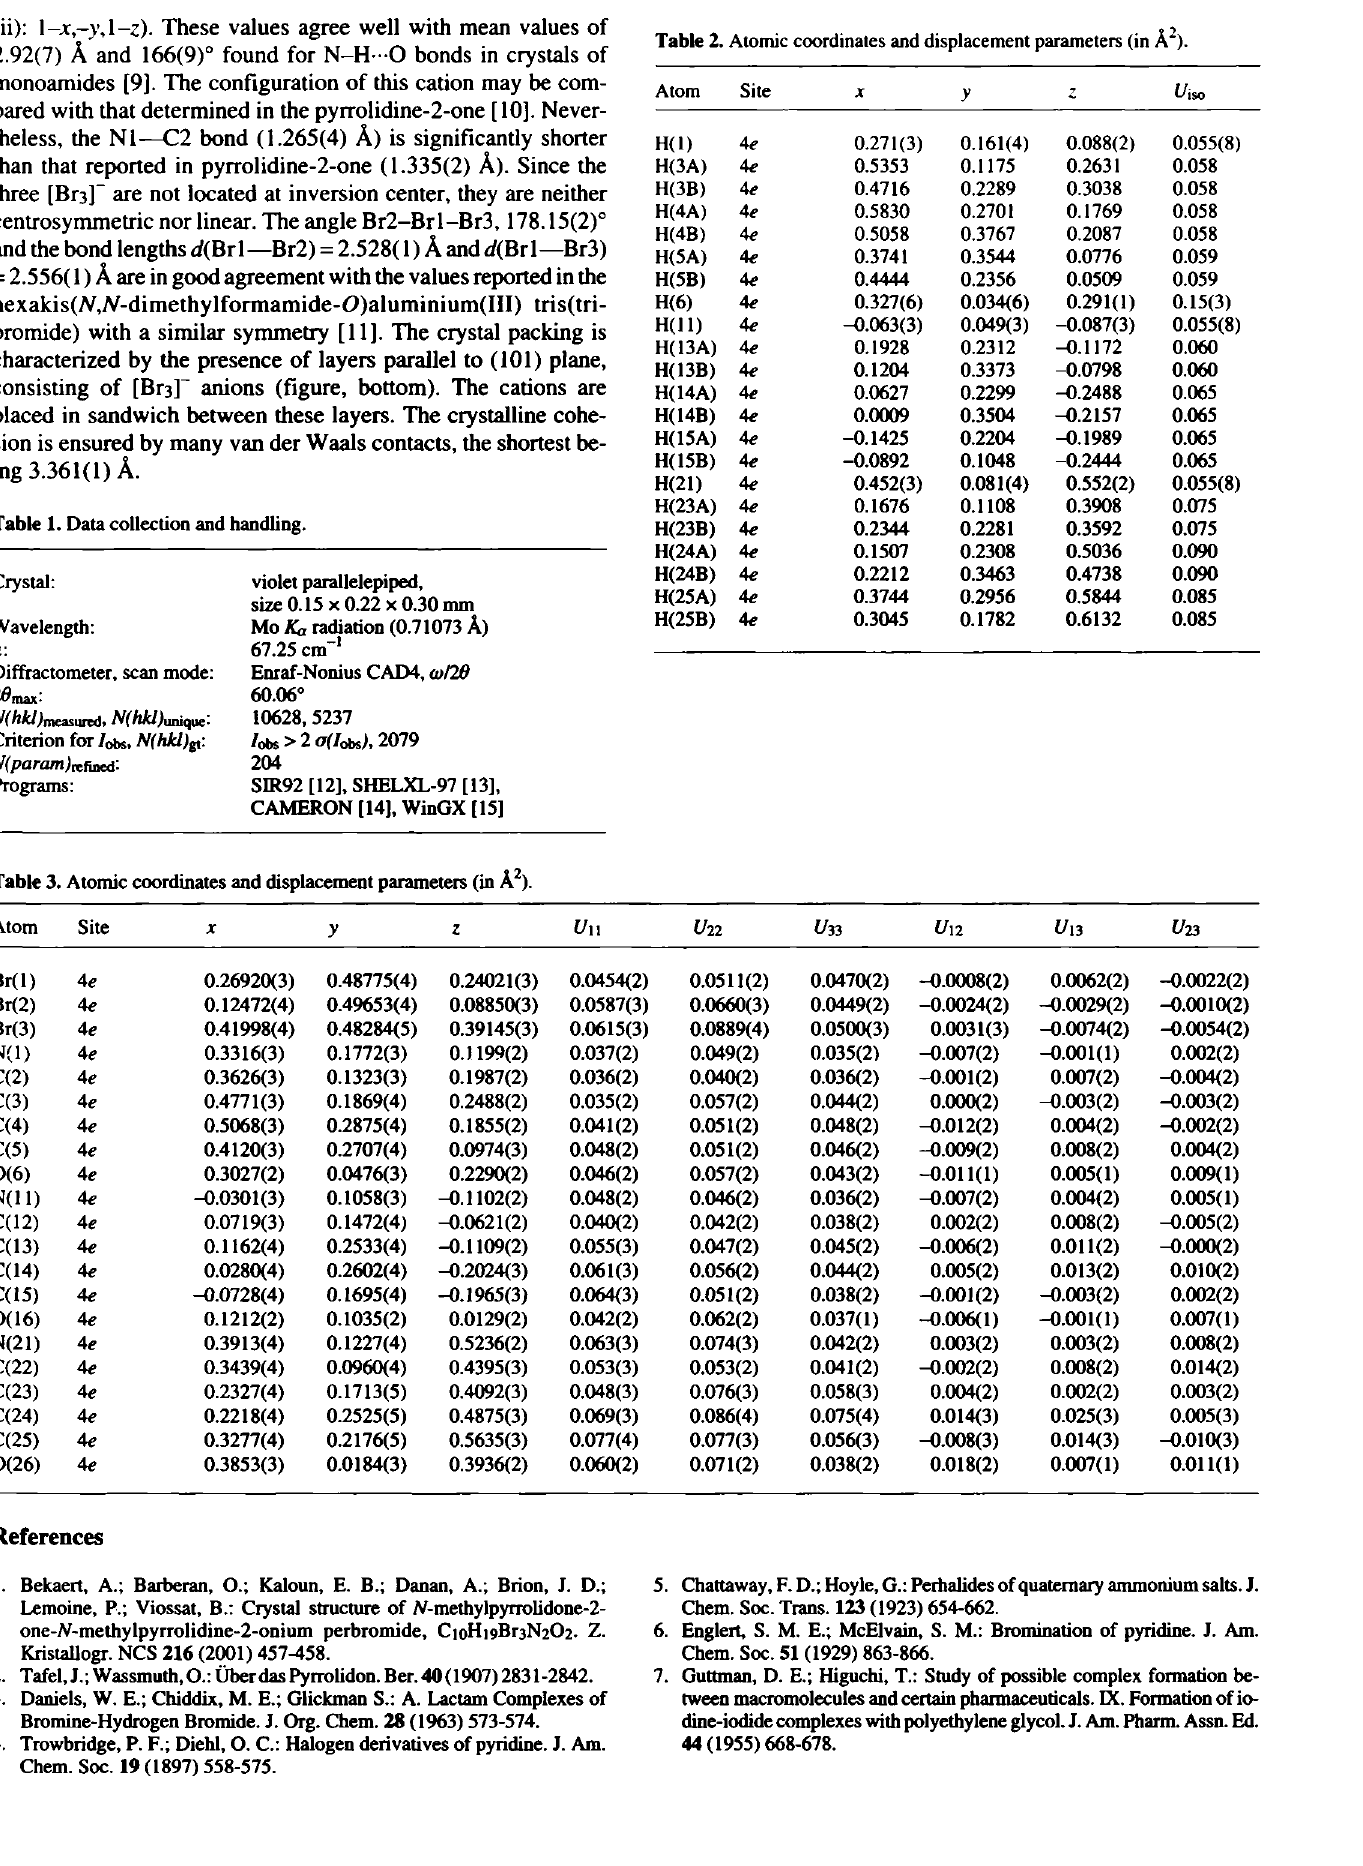
Table 2. Atomic coordinates and displacement parameters (in A 2 ).